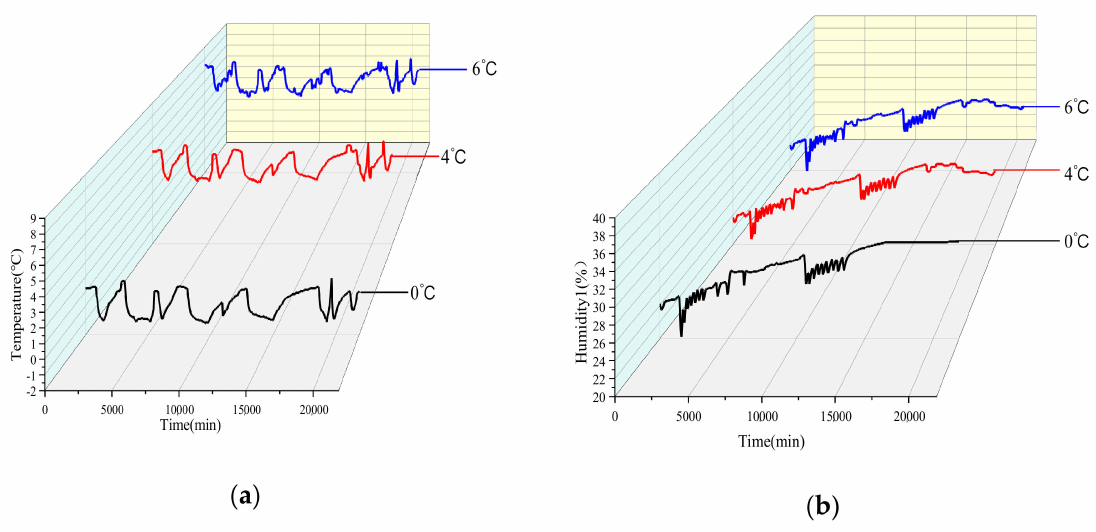
Figure 4. Temperature and humidity dynamic changes of salmon samples stored at refrigerated temperature (0 ◦ C, 4 ◦ C, 6 ◦ C) for 14 days. ( a ) Ambient temperature change; ( b ) Ambient humidity